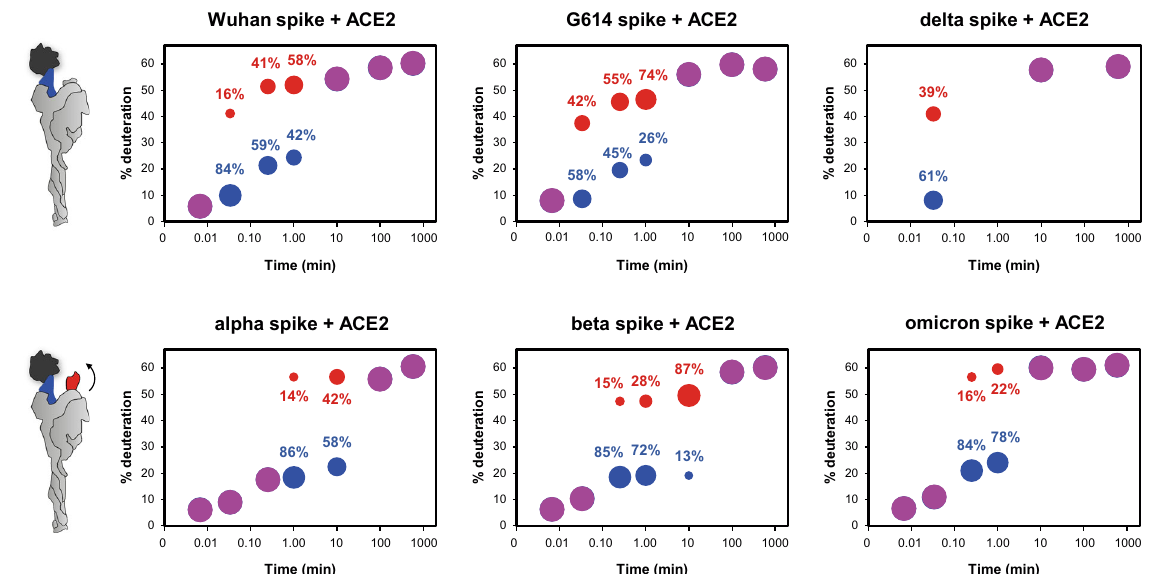
Fig. 5 | Cooperative binding (bimodal HDX in the RBM of spikes in complex withACE2). ThebubbleplotsofmodelpeptidesoftheRBMprovideanestimation ofthelevelofdeuterationandtherelativeintensityofthetwospikesubpopulations upon receptor binding. Data are indicative and semi-quantitative and need to be regarded as trends. The bubbles of the low- and high-mass population (bimodal distributions) are sized according to their approximated relative intensity and colouredinblueandredrespectively.Magentabubblesindicateunimodalisotopic